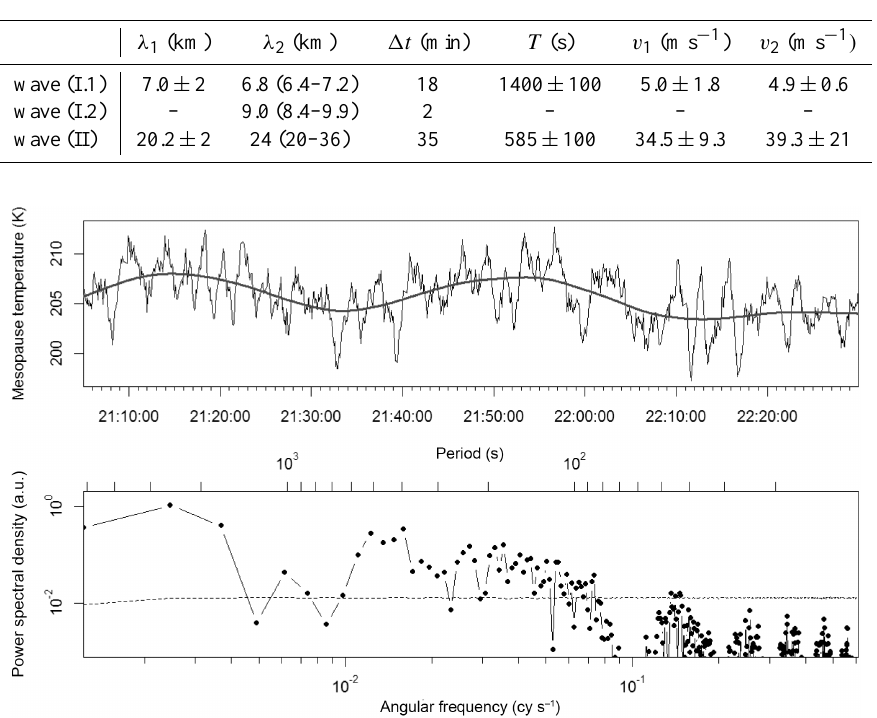
Figure 10. Upper panel: 1min running averages of the time series of GRIPS13 measuring in parallel direction with FAIM1. A smooth spline is drawn as a thick line to guide the eye and show a long-period wave structure which dissolves at the end of the shown interval. Bottom panel: Fourier transform of the temperature time series. Periods of 2500, 1000, 510 and 390s are visible in the range of higher periods. The dashed line gives the 0.95 significance. See text for further